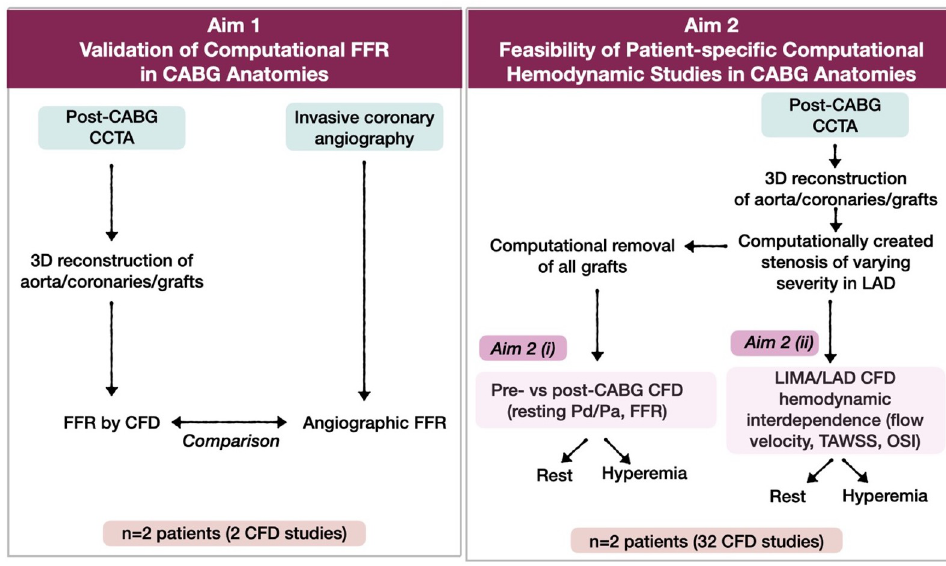
Fig 1. Study aims. (CABG: coronary artery bypass grafting, LIMA: left internal mammary artery, FFR: fractional flow reserve, CFD: computational fluid dynamics, CCTA: coronary computed tomography angiography, LAD: left anterior descending artery, TAWSS: time-averaged wall shear stress, OSI: oscillatory shear index).